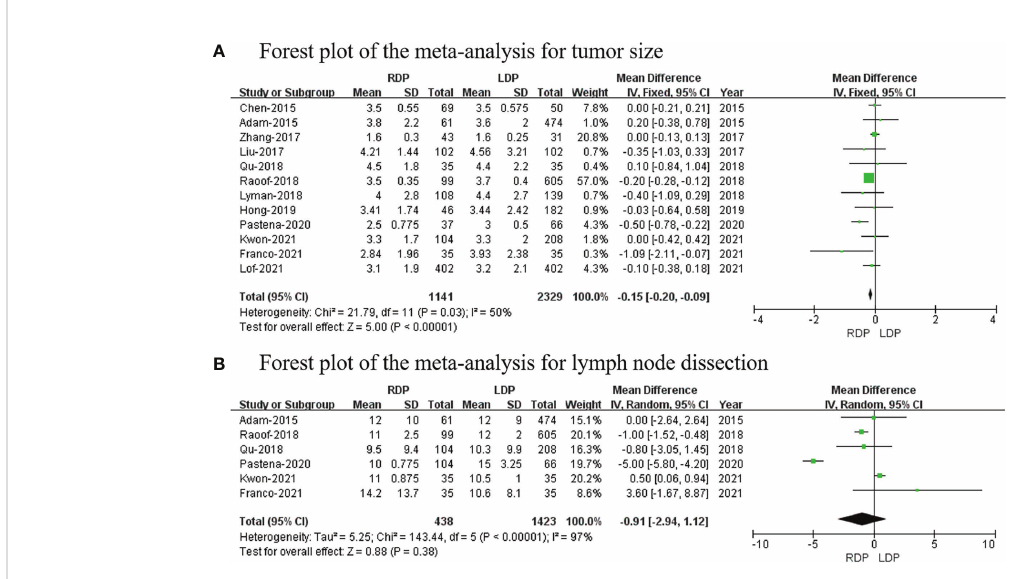
FIGURE 8 Forest plot of the meta-analysis for (A) tumor size and (B) lymph node